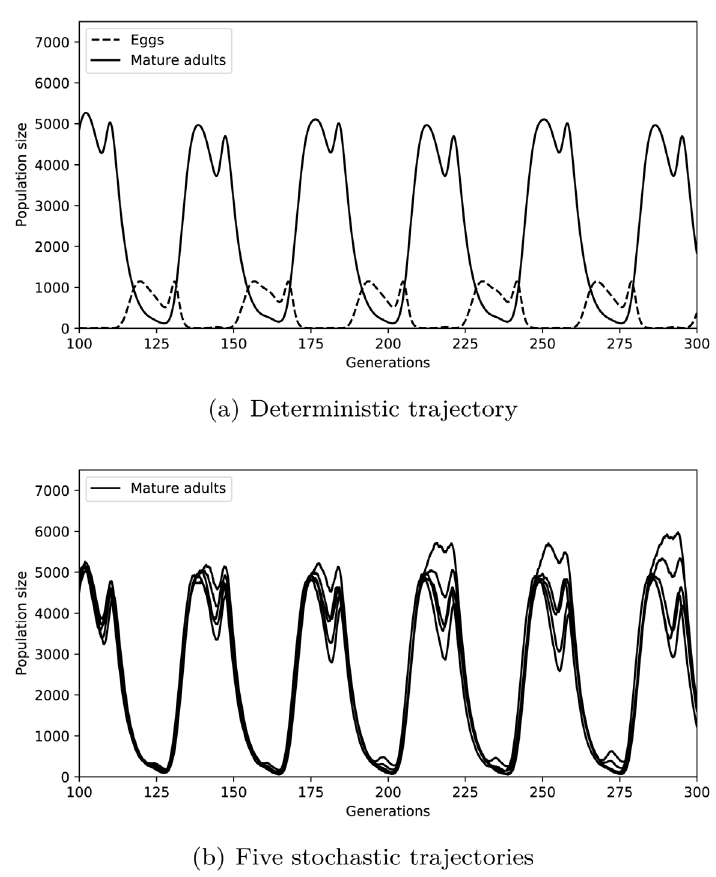
Figure 3. Age- and stage-structured model of Nicholson’s Blowflies in discrete time. In ( a ), the deterministic trajectories of eggs (dashed line) and mature adults (solid line) are shown for the corresponding generations. In ( b ), five stochastic trajectories of mature adults are shown for the same